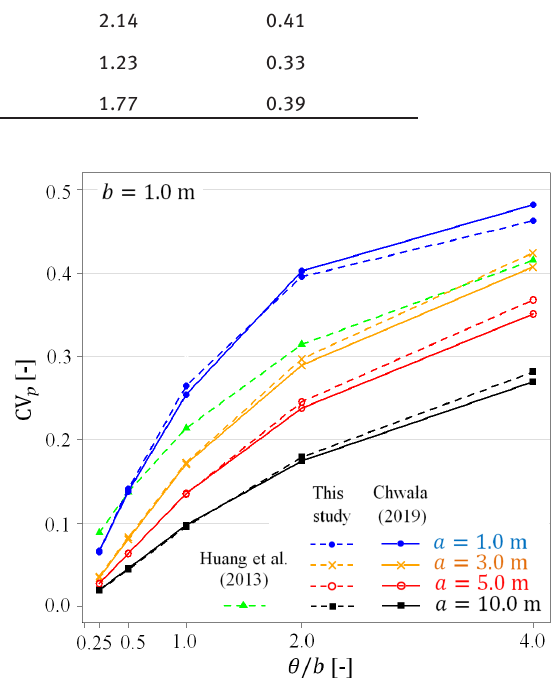
Figure 4: Comparison of bearing capacity variation coefficients obtained by the method proposed in this study (constant covariance matrix) with standard algorithm (individual covariance matrix, Chwała (2019a)). The relative differences between both approaches are below 5%, which is sufficient for the purpose of this study. A detailed description is in the text.